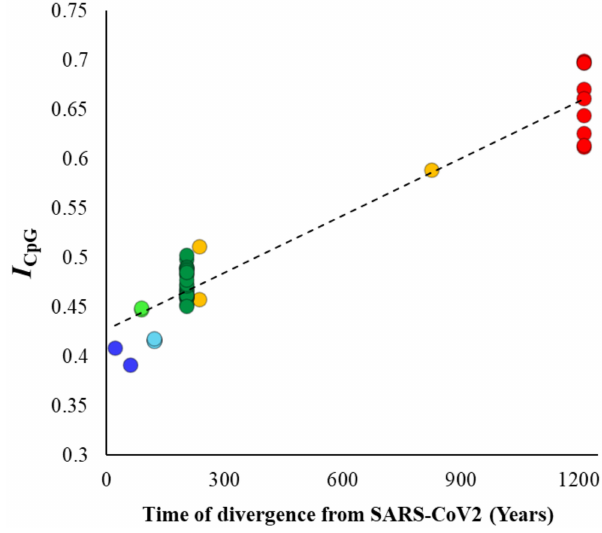
Figure 4. Correlation between the ratio of observed-to-expected CpG contents ( I CpG —Equation (2)—see methods) of the betacoronavirus genomes and their respective times of divergence from SARS-CoV-2. The relationship is highly significant ( ρ = 0.87, p <